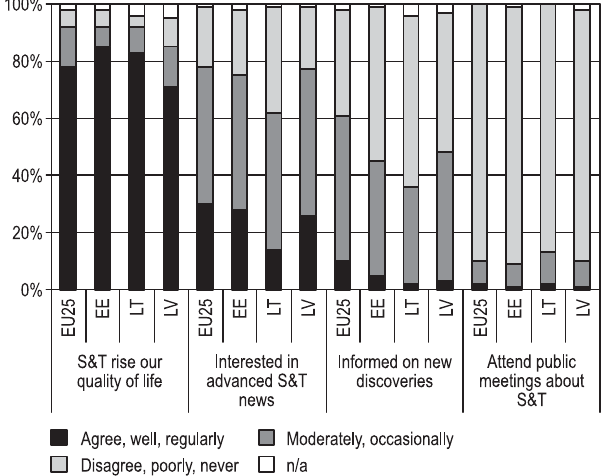
Fig. 5. Approach of the society to knowledge activities (Special Eurobarometer 2005); S&T – science and